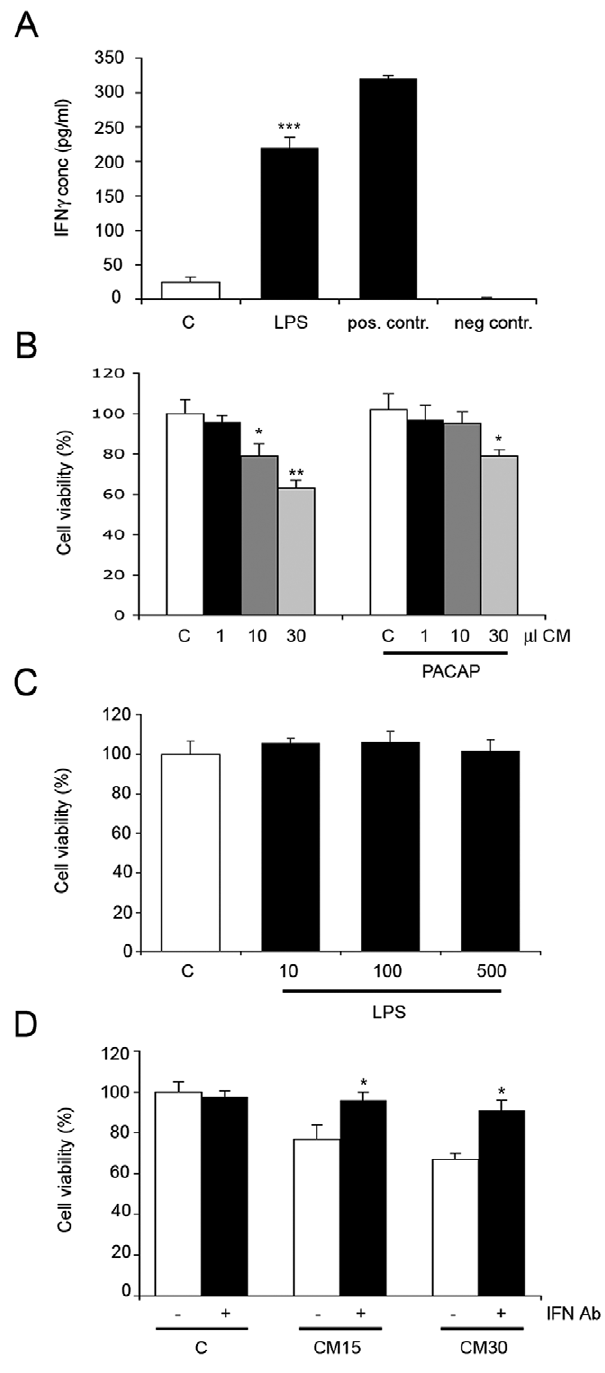
Figure 7. Microglia-conditioned medium decreases NPC via- bility. Microglial cells from rat brain were cultured and treated as described in Methods. ( A ) Activation of microglia using 500 ng/ml LPS. IFN c was studied using ELISA as described in Methods. Positive and negative controls were from the Quantikine kit. ***p , 0.001 vs. controls, n=4. ( B ) Left panels, 30 m l medium from control microglia (C) or 1– 30 m l conditioned-medium (CM) from LPS-treated microglia was added to 100 m l NPCs cultures. Values are means 6 SD n=3. *p , 0.02 and **p , 0.05 for 10–30 m l CM vs. C Right panels, 50 ng/ml PACAP was added to half the cultures and cell viability assayed after 24 h using MTT. *p , 0.05 for 30 m l PACAP + CM vs. C. ( C ) 10–500 ng/ml LPS was added directly to NPCs for 24 and cell viability studied. No change with LPS alone. ( D ) NPCs were incubated with 30 m l control medium (C) or